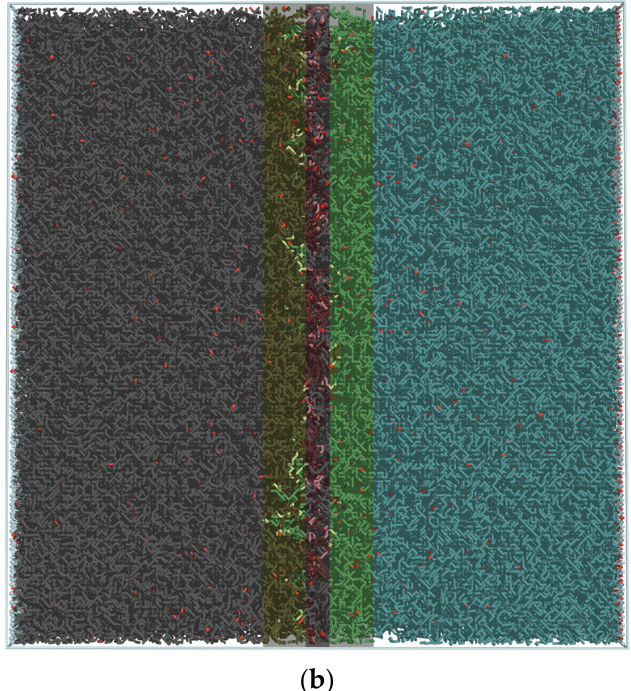
Figure 8. Configurations of an opposing brush system for σ = 0.3, DP n = 50 ( a ) and DP n = 110 ( b ). Each brush is displayed in a different color. Red dots mark the ends of the polymer chains. In ( b ) the penetration length (red bar) and density overlapping region (yellow bar) are indicated. Light grey chains are indicated as having a direct contact with opposing layer.